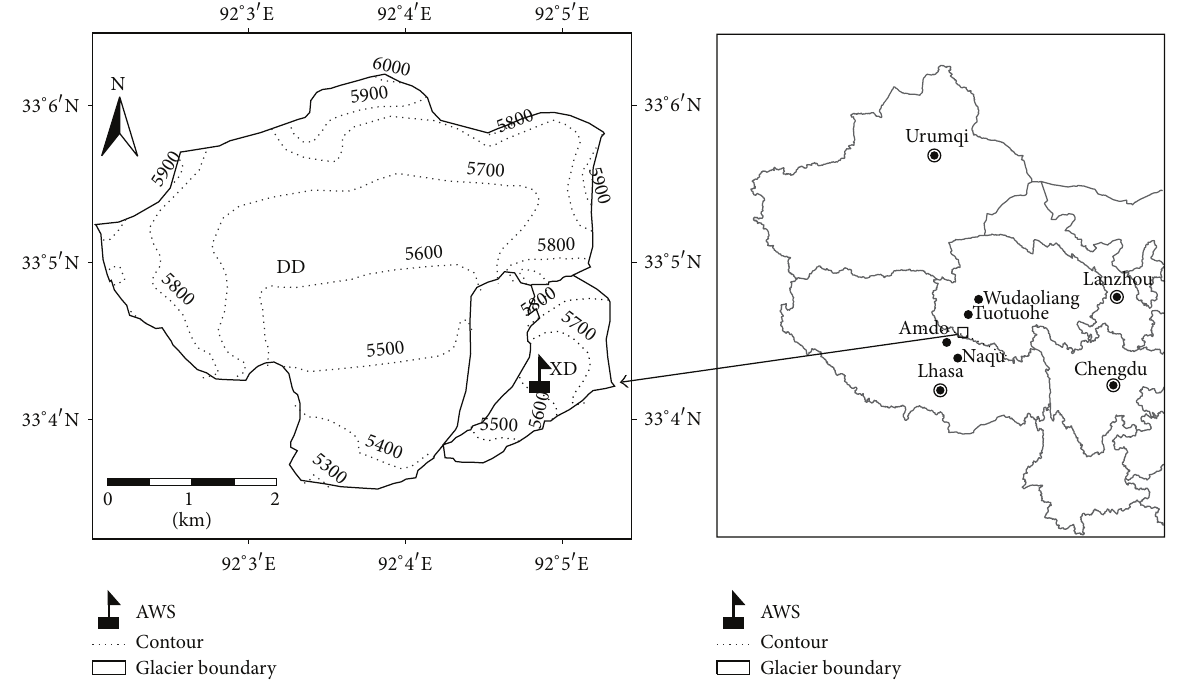
Figure 1: The location map of Dongkemadi glacier, indicating the AWS on the glacier and four national weather stations